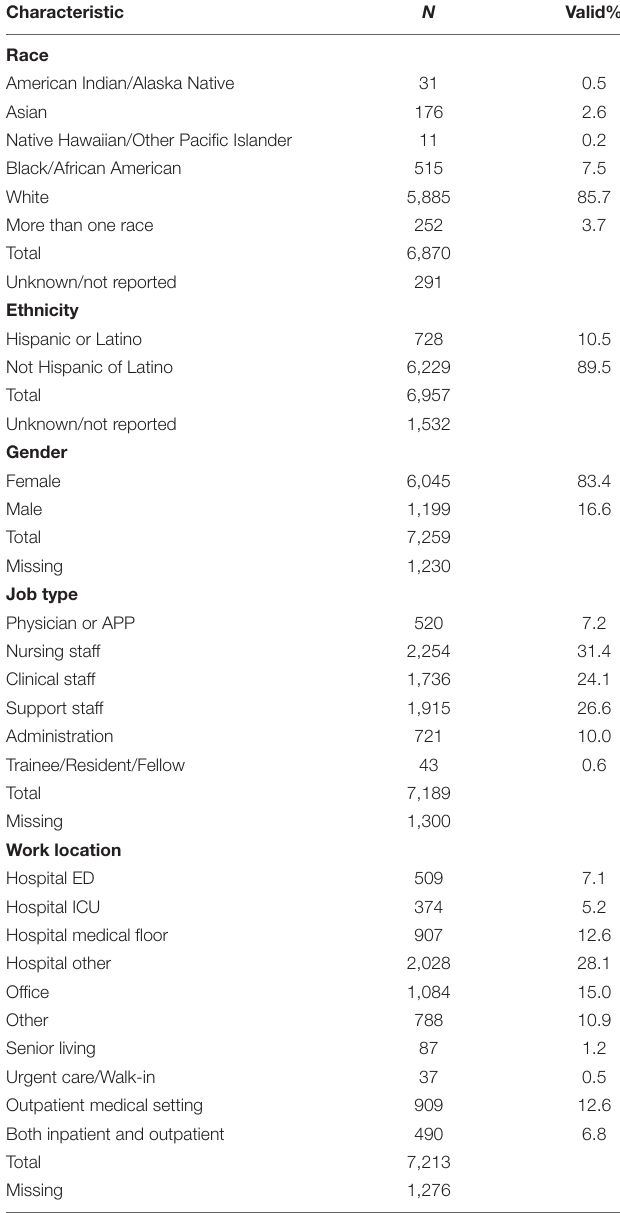
TABLE 1 | Demographic data of